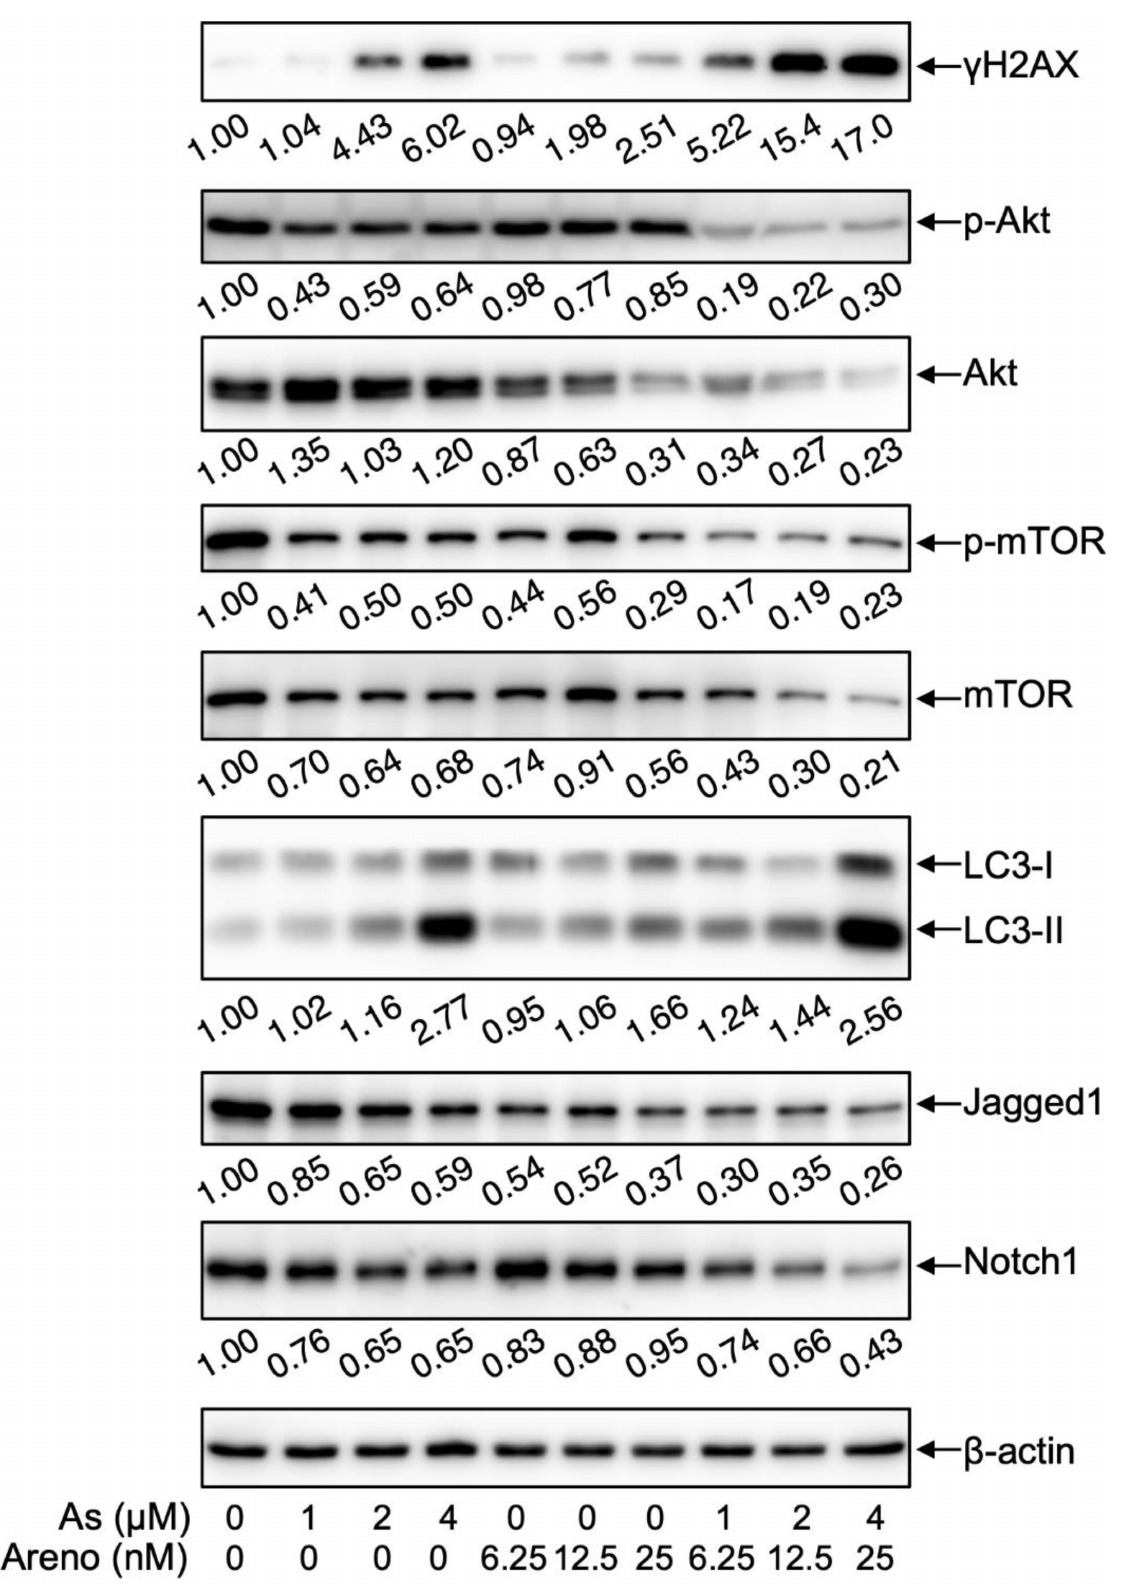
Figure 9. Alteration of DNA damage-, autophagic cell death-, and Jagged1/Notch signaling-related gene protein expression in U-87 cells treated with As III combined with arenobufagin. Following treat- ment for 48 h with As III (1 and 2 µ M) and arenobufagin (6.25 and 12.5 nM), alone and in